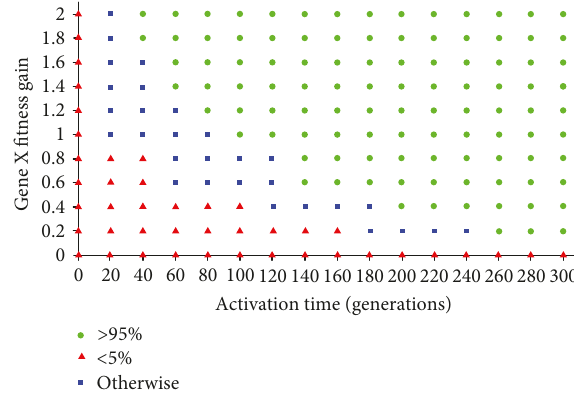
Figure 20: Rate of successful invasions within 10 5 generations in 20 simulations, for di ff erent combinations of activation time and gene X gain.